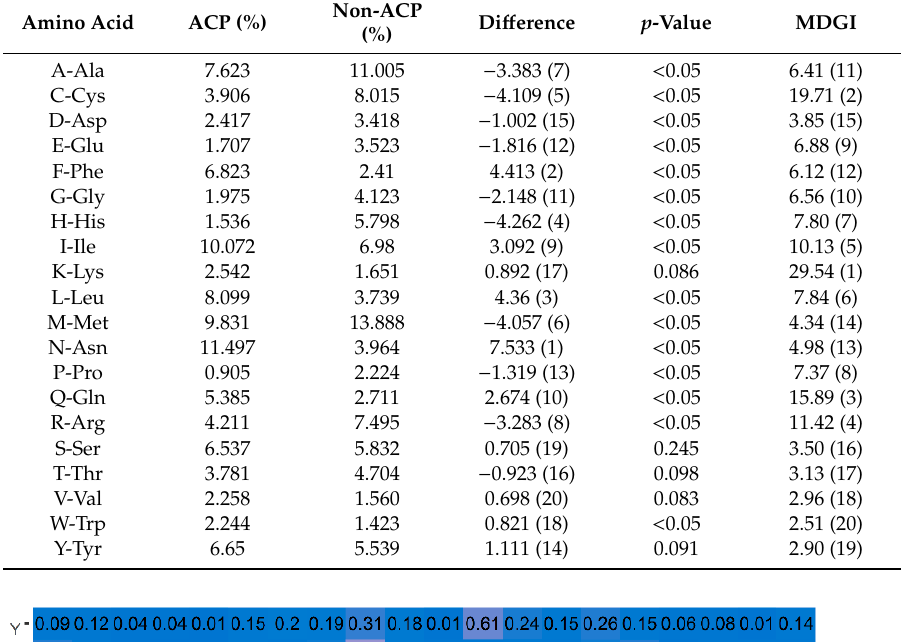
Table 5. Amino acid compositions (%) of anticancer and non-anticancer peptides along with their di ff erence as well as MDGI values. The rank of each amino acid amongst their 20 amino acids are shown in parenthesis for AAC di ff erence and MDGI.